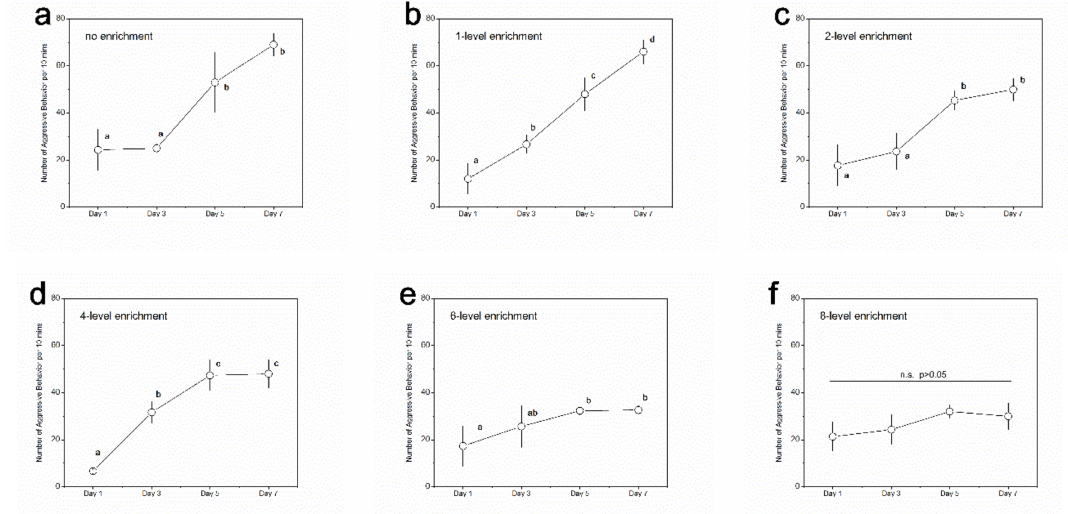
Figure 3. Levels of aggressive behavior in black rockfish among experimental days within a specific treatment group. ( a ) No enrichment group; ( b ) 1-level enrichment group; ( c ) 2-level enrichment group; ( d ) 4-level enrichment group; ( e ) 6-level enrichment group; ( f ) 8-level enrichment group. Different letters indicate significant differences among experimental days within a specific treatment group. n.s. indicates no significant difference. n = 3. Data are presented as means ± S.E.